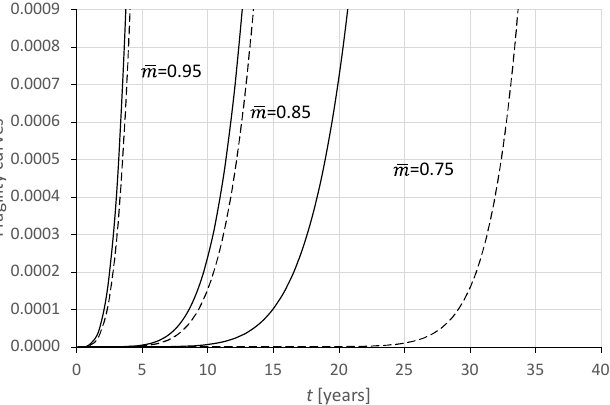
Figure 10. Error made in the probabilistic evaluation of the time to reach a certain damage threshold considering the fragility curves obtained for scenario 1 and the fragility curves defined as “statistical truth” (with probability less than 9 × 10 − 4 ).